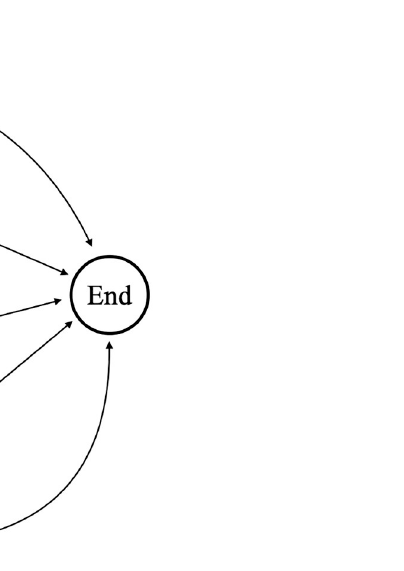
Fig 5. Model B5. 5-state model (B5) used to determine tail addition in previous studies.